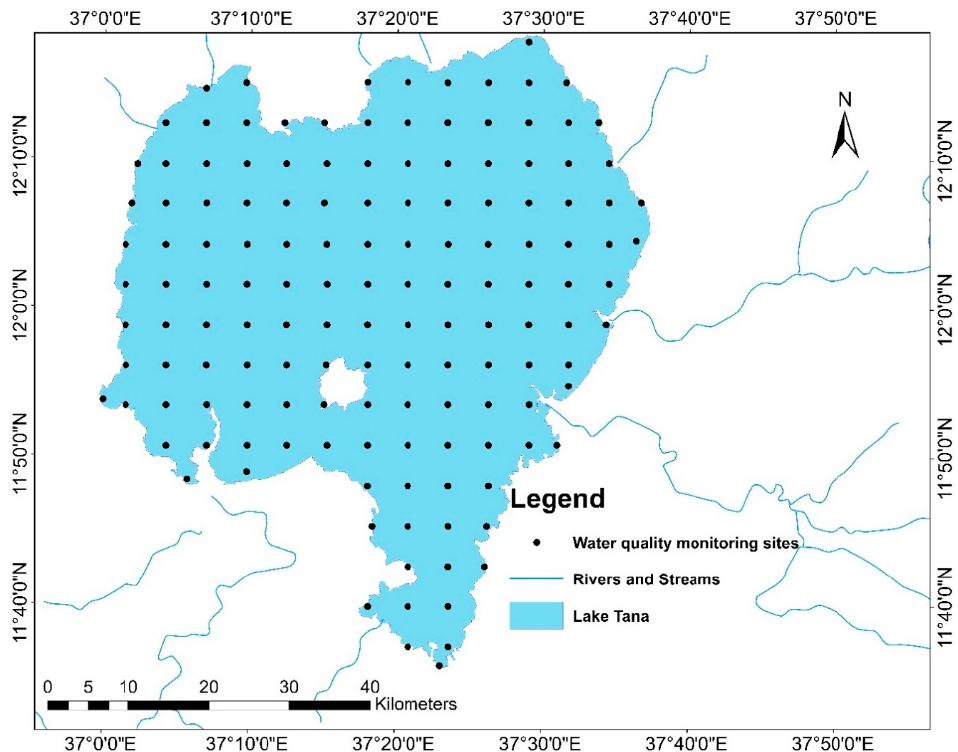
Figure 2. Lake water quality data sampling sites (Collected in August, December 2016, and March 2017).